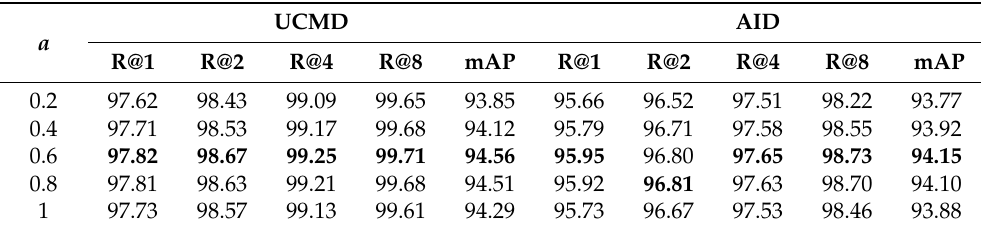
Table 4. Validation of the parameter a on UCMD and AID. The best results are shown in bold.